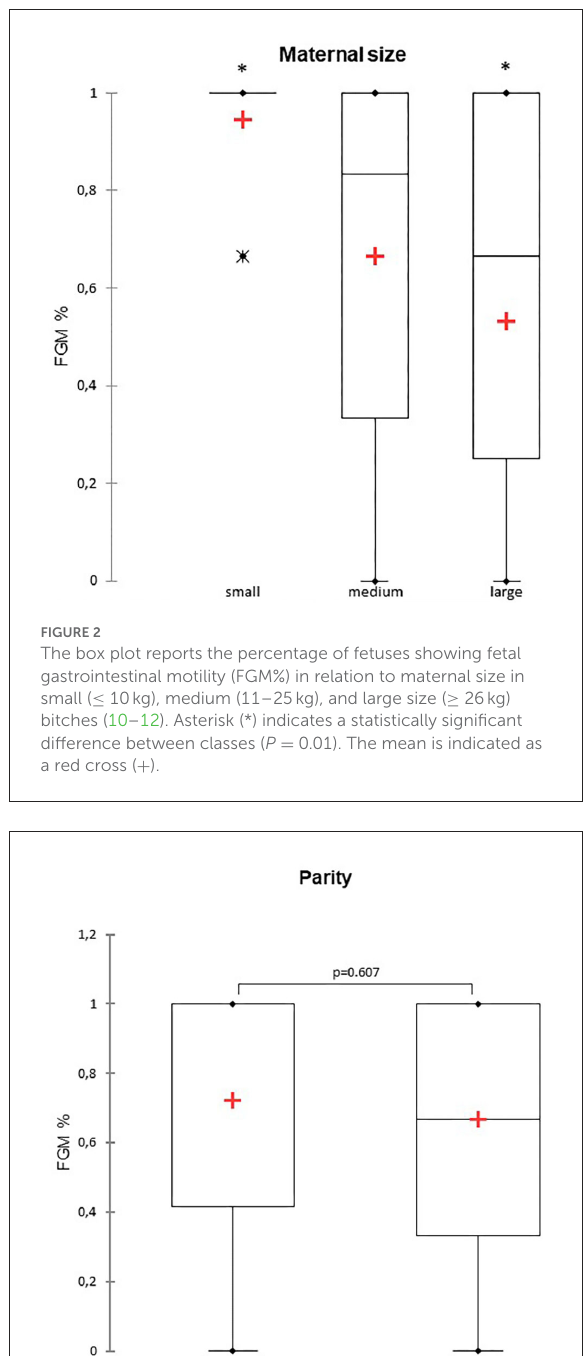
detected by US. Pregnant bitches were divided into two groups, depending on the type of parturition (natural vs. C-section).